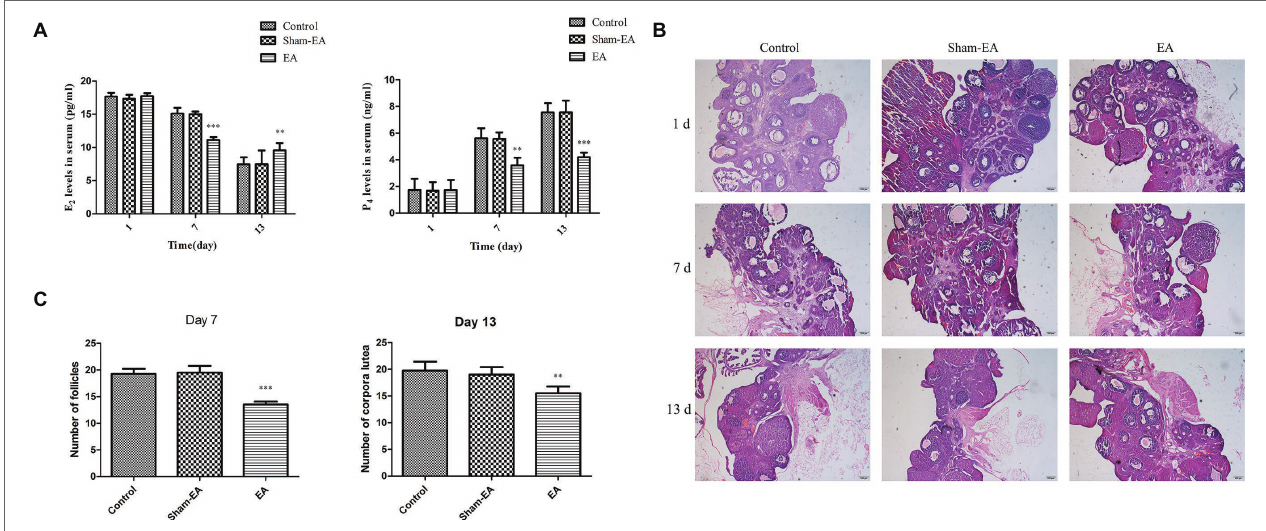
FIGURE 4 | Serum E 2 and P 4 levels at day 1, 7, and 13 after EA treatment. (A) Serum E 2 and P 4 levels. * indicates the changes of the hormone levels are different between the EA-treated rats and Control or Sham-EA group rats. (B) Morphological analysis of ovaries from day 1, 7, and 13. Scale bars represented 200 μm. (C) The number of follicles from Control, Sham-EA, and EA group rats at day 7 and the number of corpora lutea in three group rats at day 13. * indicates the changes of follicles or corpora lutea are different between the EA-treated rats and Control or Sham-EA group rats. Data are presented as means ± SD, ** p < 0.01, *** p < 0.001.